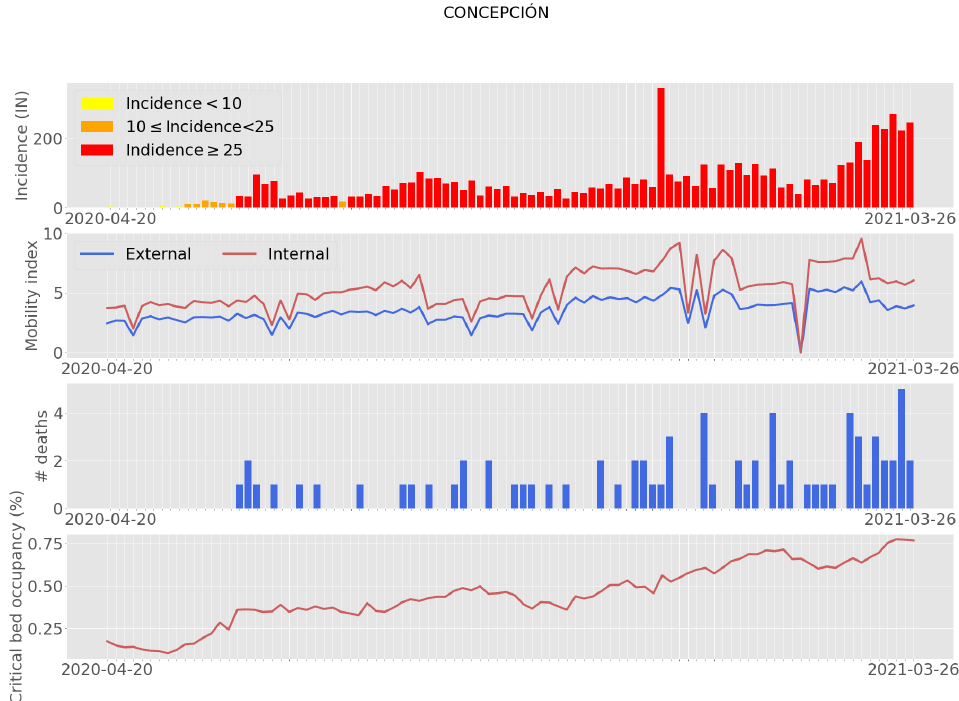
Figure 1. Evolution of some COVID-19 features together with the incidence behavior over the study